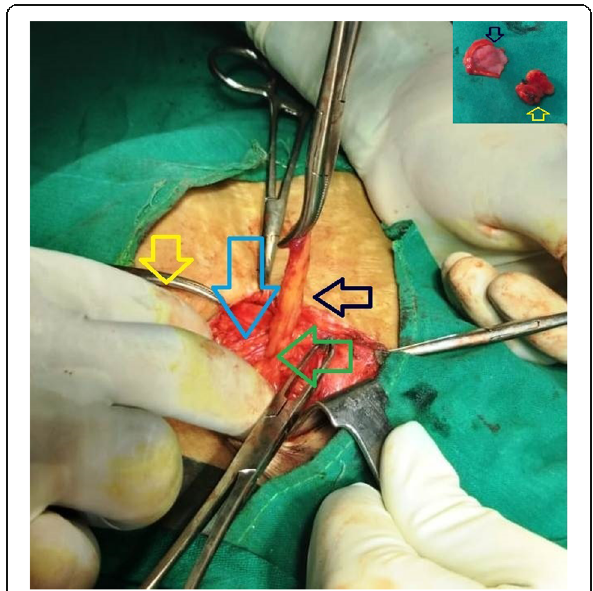
Fig. 4 Femorocele sac (black arrow) coming out of the femoral ring (green arrow), and it is below the inguinal ligament (blue arrow). Yellow arrow, enlarged superficial inguinal lymph node. Inset: excised femorocele sac (black arrow) and harvested superficial inguinal lymph node (yellow arrow)